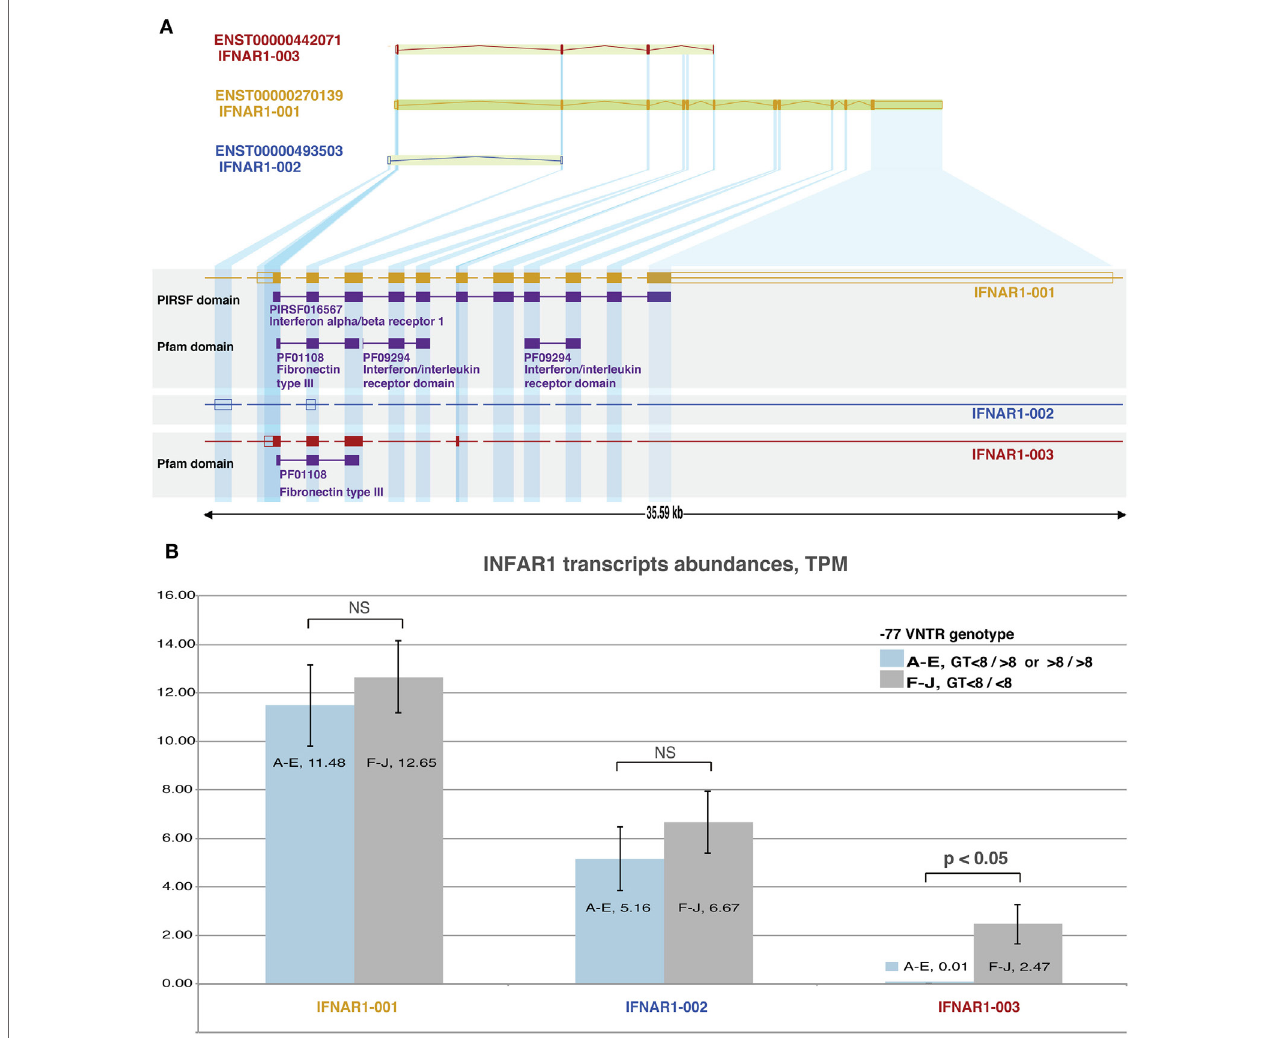
FigUre 2 | Analysis of IFNAR1 transcripts: (a) structure of IFNAR-1 gene. Alternative splicing and transcription initiation sites produce three distinct transcripts that differ in length. Only transcripts 001 and 003 are translated into proteins, which share only the C-terminal part and a fibronectin type III domain. (B) : RNAseq- derived expression levels of the three transcripts from 10 hepatocellular carcinoma (HCC) samples grouped based on their − 77VNTR(GT)n genotype. The levels of transcripts 001 (responsible for the production of the receptor) and 002 do not differ significantly between the genotypes. Transcript 003 is expressed only in samples with < 8/ < 8 (GT)n repeats in the − 77VNTR polymorphism. The genotypes of HCC RNA samples (A–J) are described in Table 1